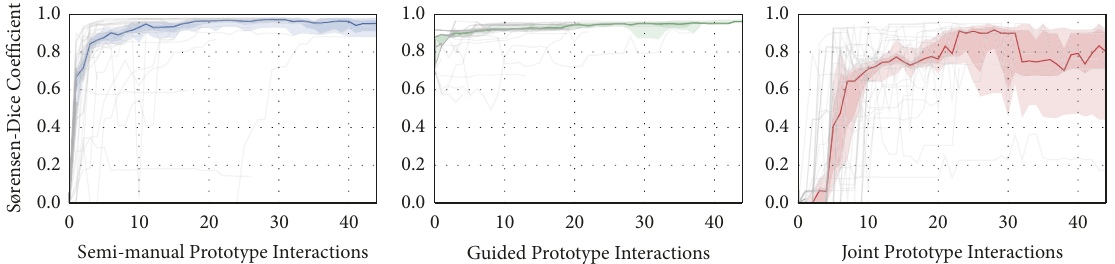
Figure 12: Evaluation of the user interaction data. The segmentations’ similarity to the ground truth according to the Dice score is depicted per interaction. The median Dice rating and the 75 % and 95 % confidence intervals are illustrated.